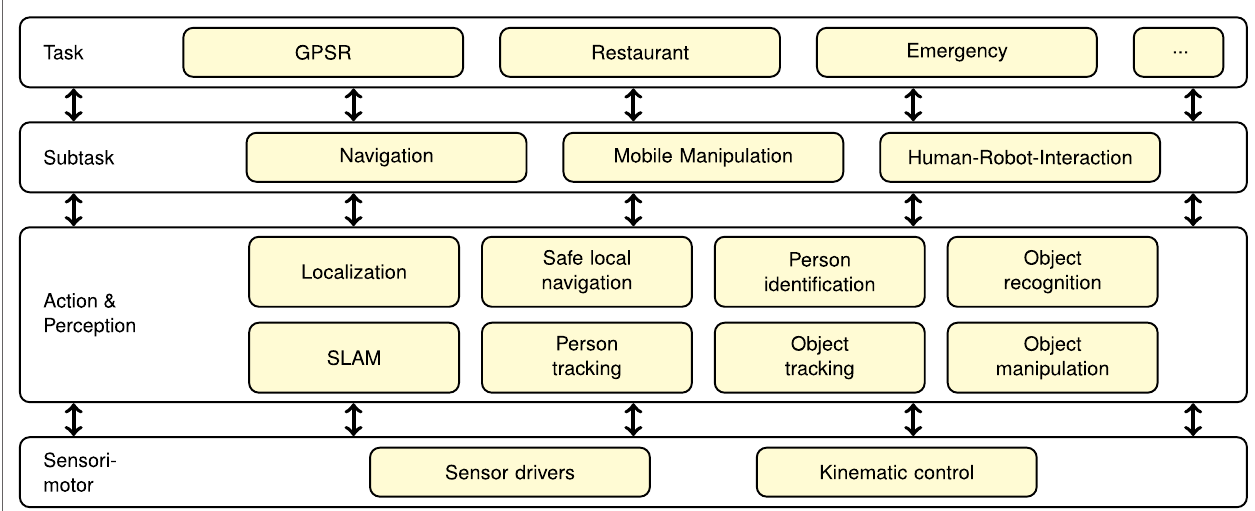
FIgURe 3 | overview of the software architecture of cosero